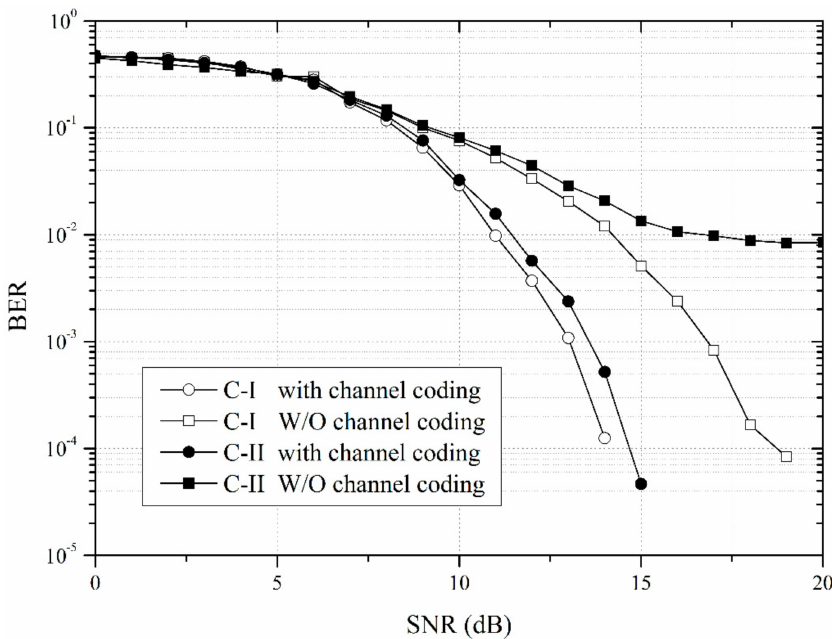
Figure 5. Bit error rate (BER) versus SNR for Case-I and Case-II (with and without channel coding) [15].